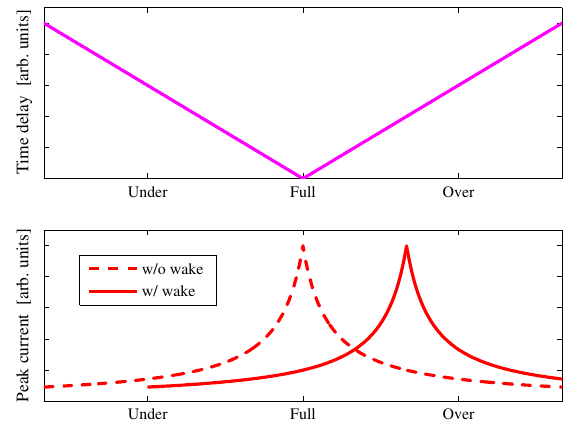
FIG. 4. A schematic representation of time delay (up) and peak current (down) versus the compression mode. The dashed line is without the wakes and the solid line is with the